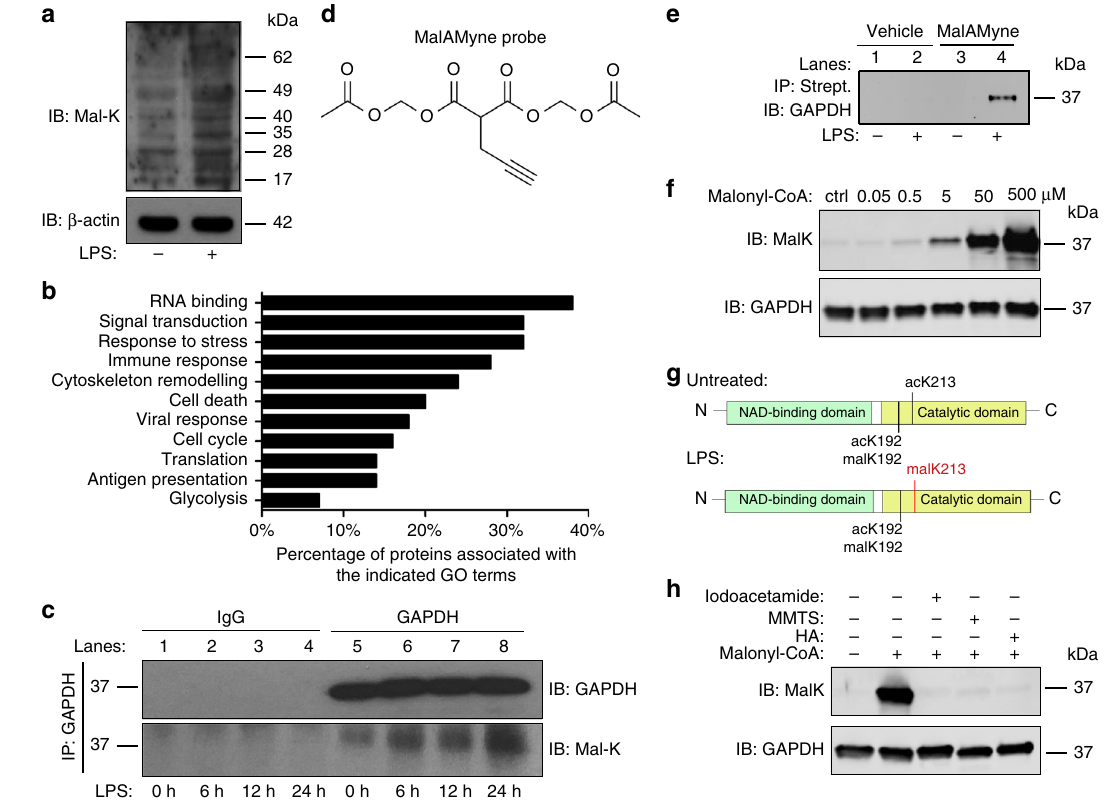
Fig. 2 Activation of macrophages with LPS increases protein malonylation, with GAPDH as a substrate. a Western blot analysis of lysine malonylation (mal-K) in lysates from BMDMs treated with LPS (100 ng/mL) for 24 h. b Most enriched functions associated with LPS-induced malonylated proteins (FDR < 0.05). c Immunoprecipitated GAPDH from untreated and LPS-treated (100 ng/mL, 6, 12 and 24 h) BMDMs and samples probed with an anti-malK antibody (lower panel). GAPDH expression in the immunoprecipitated (upper panel) samples was also examined. d Chemical formula of the MalAMyne probe. e Untreated and LPS-treated (100 ng/mL, 24 h) BMDMs were labelled with MalAMyne (10 µ M) or vehicle control. Copper-catalysed click chemistry was performed on the lysates using biotin, followed by immunoprecipitation using streptavidin (strept.). Samples were probed for GAPDH via western blotting. f Puri fi ed GAPDH (100 µ g/mL) was incubated in the presence of TCEP and malonyl-CoA (or buffer as control) for 1 h at 37 °C, pH 7.5. K-malonylation was assessed by western blotting. g Identi fi cation of malonylated sites in immunoprecipitated trypsin-digested GAPDH peptides from untreated and LPS-treated BMDMs (10 6 cells). Peptides were analysed via LC – MS. h Puri fi ed GAPDH was preincubated with TCEP and 25 mM K-malonylation was assessed by western blotting. All data shown are representative of three independent